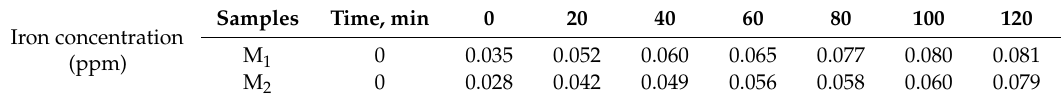
Figure 9. 4-CP mineralization efficiency measured using the photo-Fenton experiments at initial 4-CP concentration: 20 mg/L, pH: 3, 0.05 g/L catalyst loading and 2 mL of H 2 O 2. Table 3. Iron leaching in solution with different reaction time in the both raw materials system.